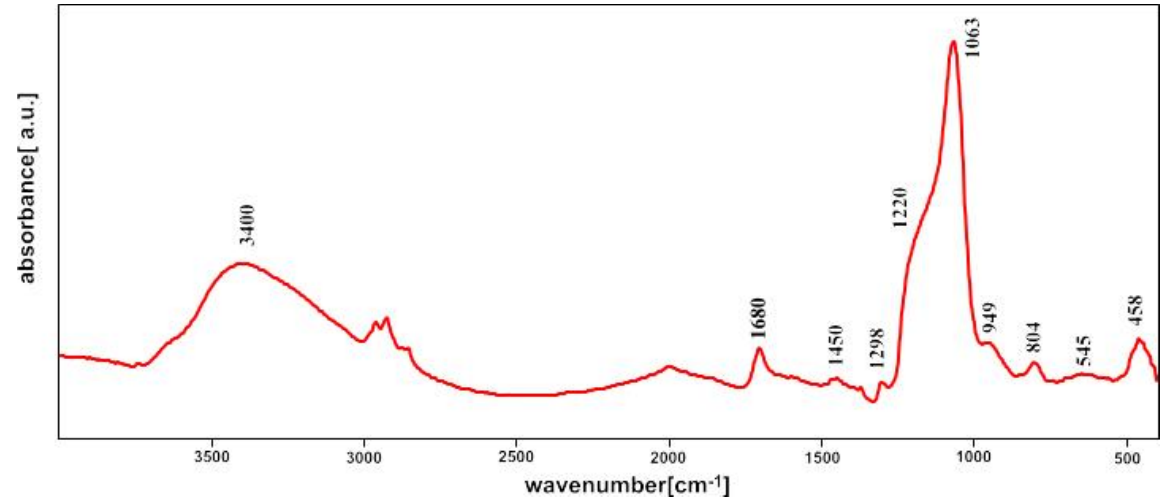
Figure 4. FTIR spectrum of the thin film prepared from the sol containing TEOS and DDS and deposited on steel substrate.